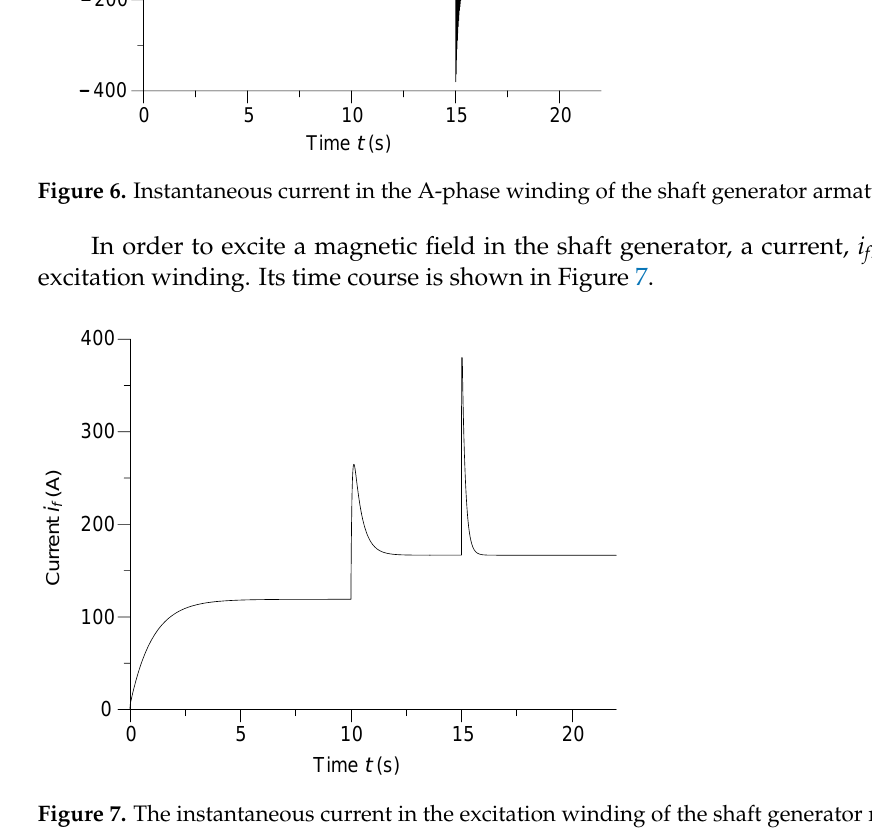
Figure 8 shows the instantaneous flux linkage for the A-phase armature winding of the shaft